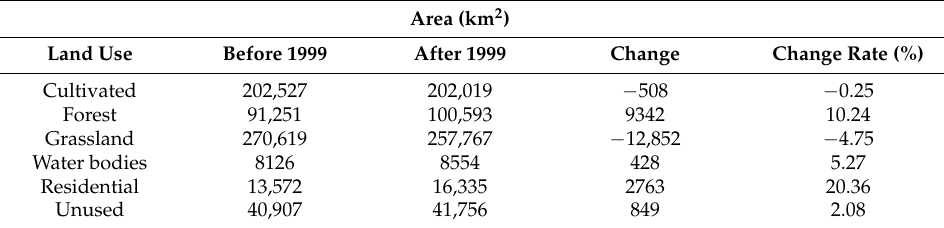
Table 4. Land use/cover change (LUCC) in 1990 and 2010 in the Loess Plateau.